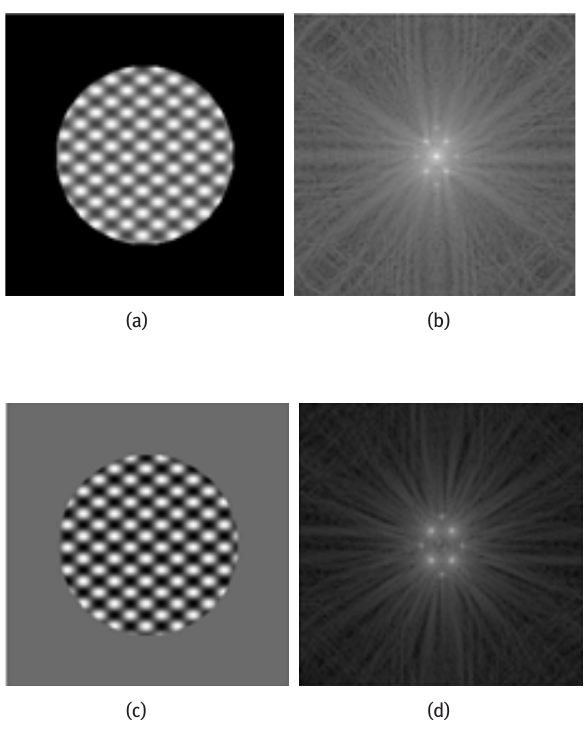
Figure 2: (a) Simulated tagged image, (b) Fourier transform of image a, (c) Tagged image after DC component subtraction and (d) Fourier transform of image